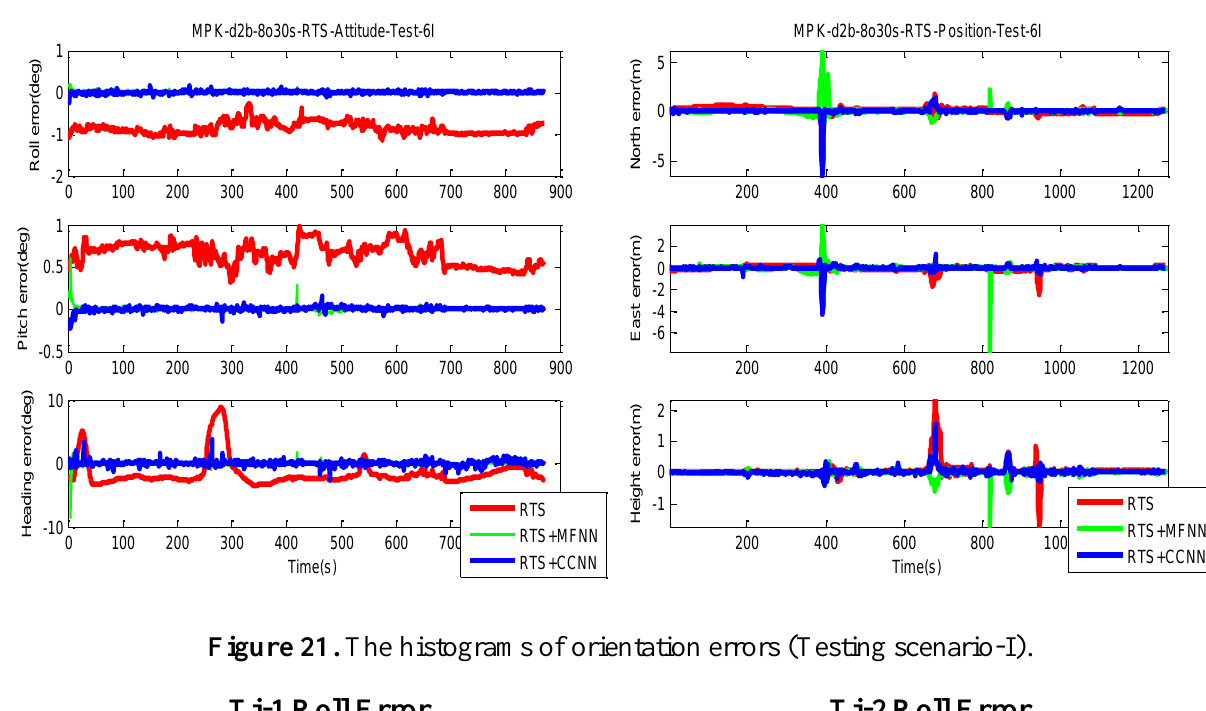
Figure 20. The samples of compensated positional and orientation errors (Testing scenario-I with trojectory_2).